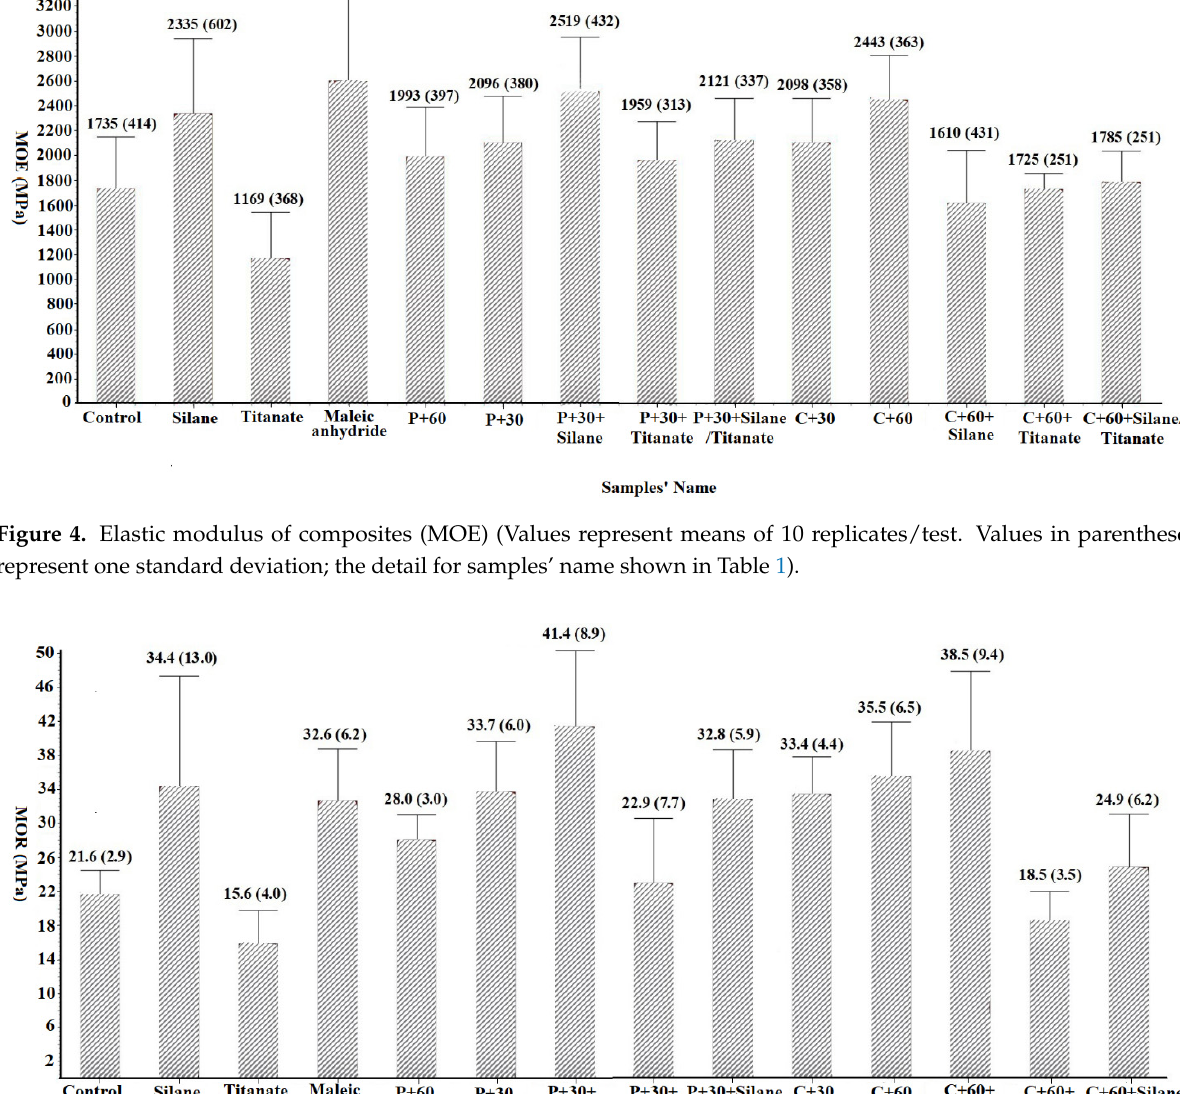
Figure 3. The water absorption for 24 h (WA 24h ) of composites (Values represent means of 10 replicates/test. Values in parentheses represent one standard deviation; the detail for samples’ name shown in Table 1).